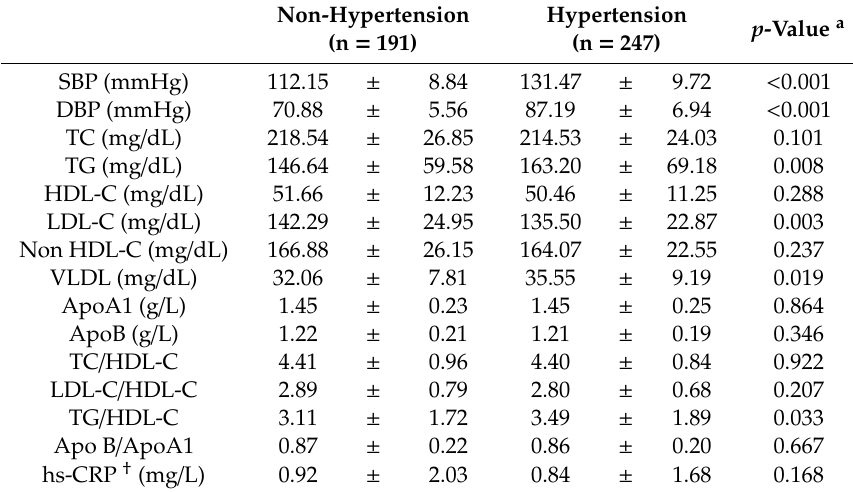
Table 2. Cardiovascular risk